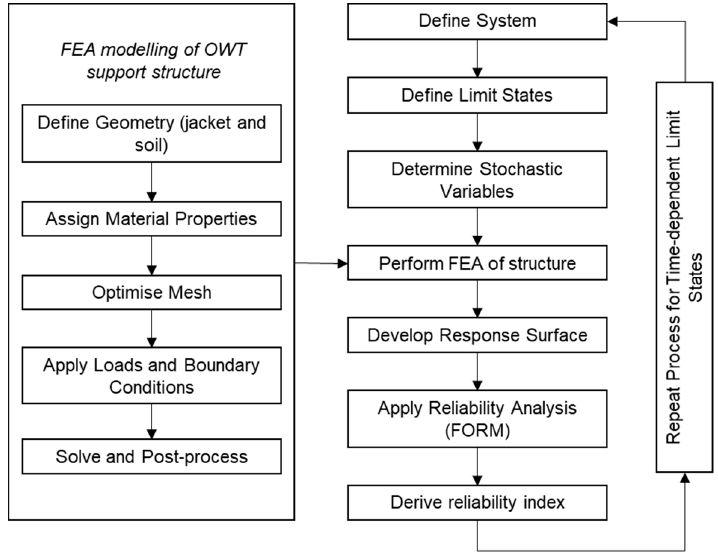
Figure 1. Flow chart of the non-intrusive formulation method [2].